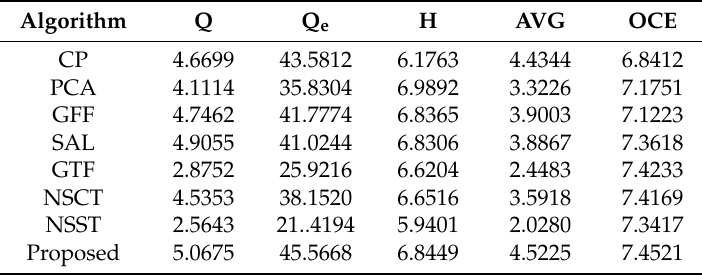
Table 2. Comparison of evaluation results of second experiment.